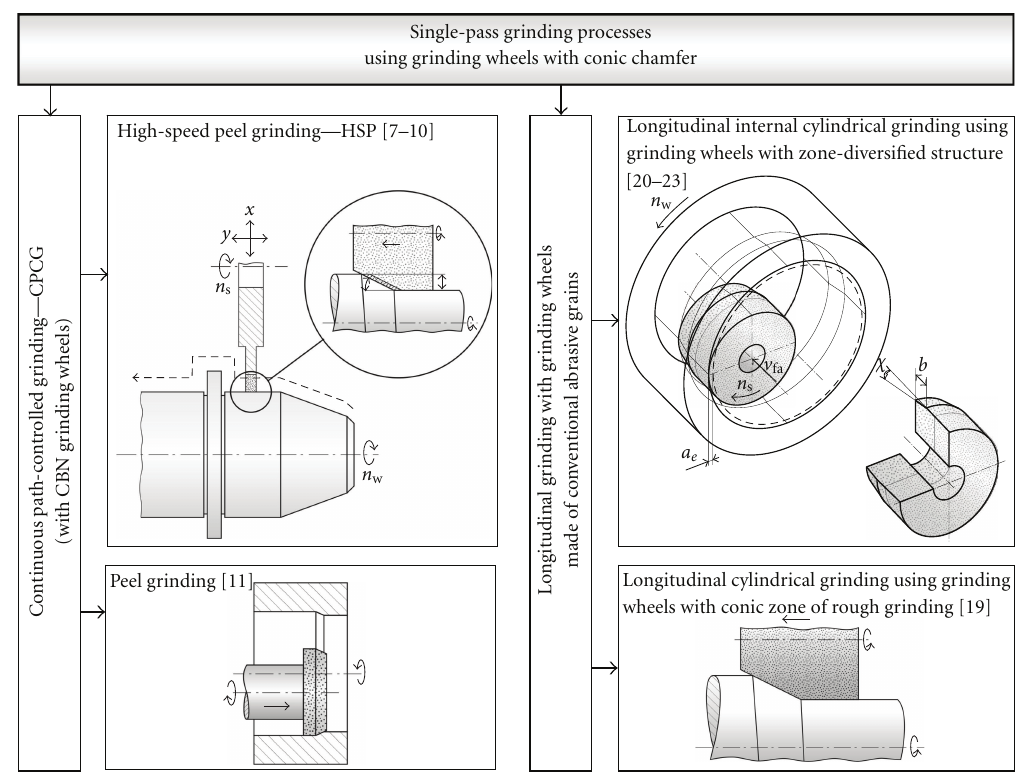
Figure 3: Single-pass grinding processes carried out using grinding wheels with conic